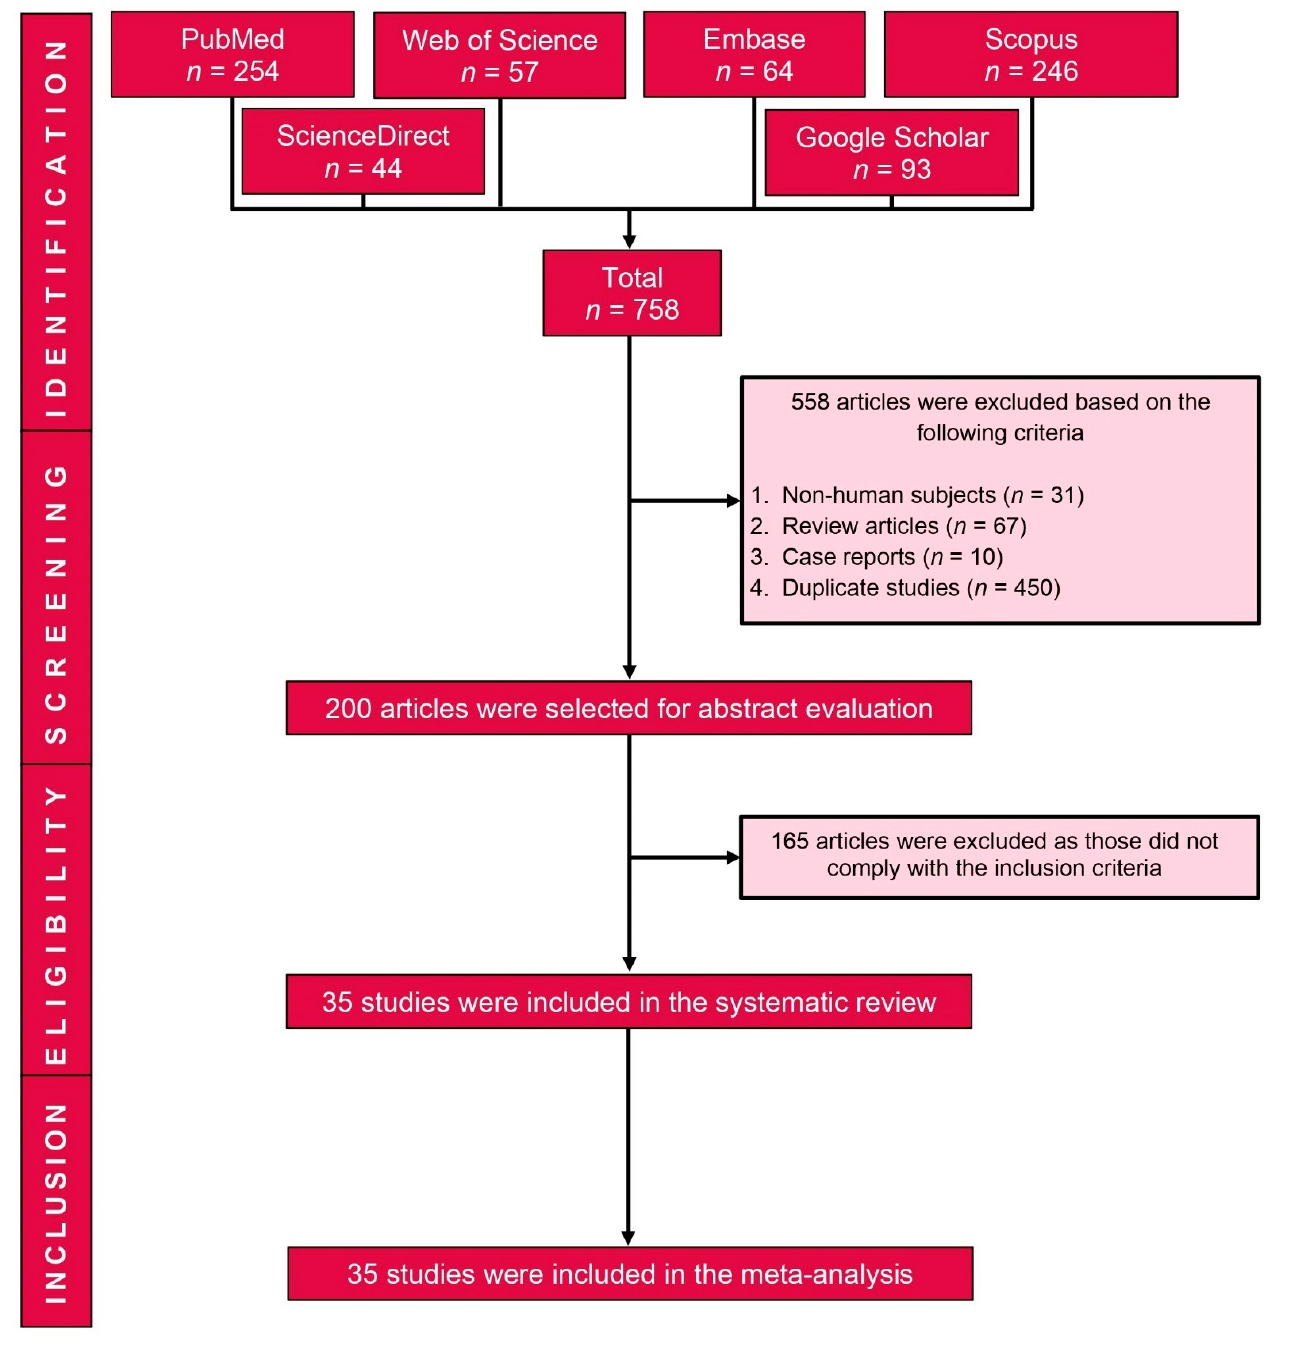
Figure 1. PRISMA flow diagram of study selection.